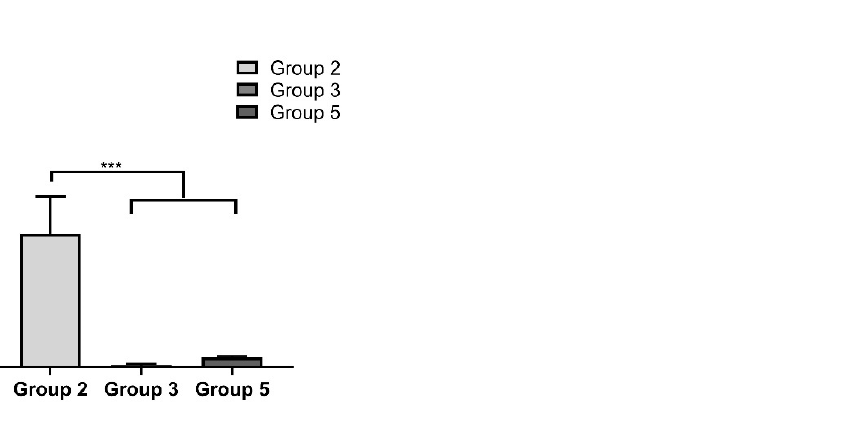
10 of 20 Figure 8 . Percentage LVFS measurements for Groups 1, 2, 3, 4, and 5 at baseline, 48 h post ligation, 60 min, 24 h, 48 h, and 1-week post injections. The data have been presented as mean ± SD ( n = 5). *** p < 0.001 was considered highly significant and ** p < 0.01, * p < 0.05 was considered significant based on Tuckey’s post hoc analysis.